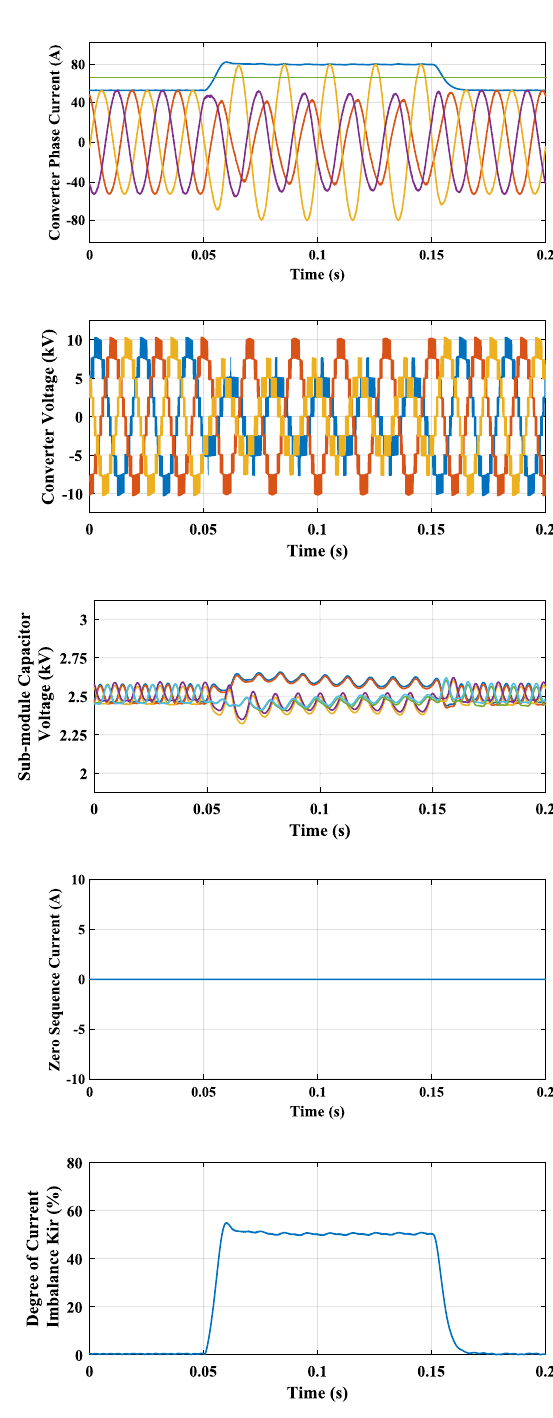
Fig. 9 Simulation result using negative sequence current injection technique. a Converter Phase currents. b Converter output voltage. c Inter-cluster dc sub-module capacitor voltages. d Zero sequence current. e Degree of current